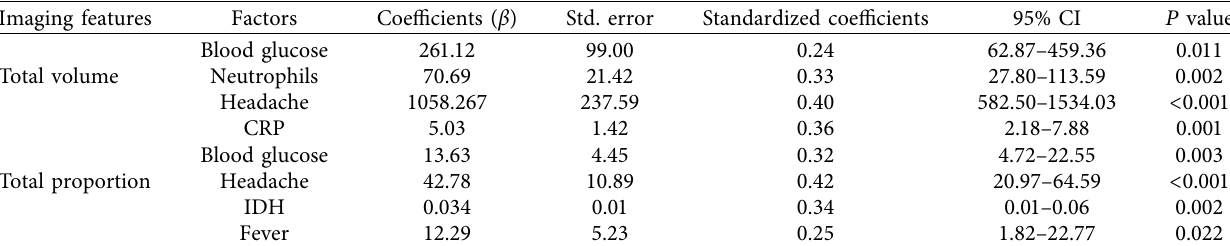
Table 3: Multiple regression analysis of factors affecting consolidation features ∗ .